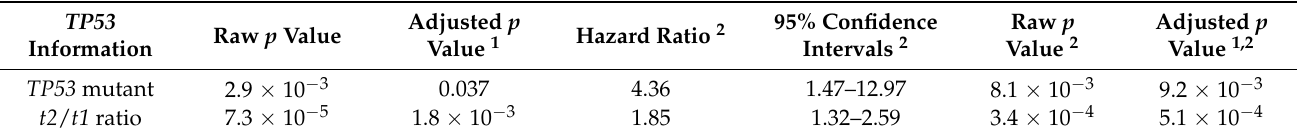
Figure 6. Association of TP53 tumor information with distant metastases free survival in NZ breast cancer patients. ( a ) Kaplan–Meier curves showing the proportion of patients having a distant metastatic event by their TP53 tumor mutation status (log rank test p = 0.0015). Red line = patients with tumors with a TP53 mutation ( n = 31), Blue line = patients with tumors with no TP53 mutation ( n = 58). ( b ) Forest plot showing contribution of TP53 tumor information and clinicopathological features to a multivariable Cox proportional hazards model predicting those patients having a distant metastatic event ( n = 83 with 27 patients developing distant metastases before 12 years, log rank test p = 4.2 × 10 − 8 ), CI = 95% confidence intervals, ( c ) Kaplan–Meier curves showing the proportion of patients having a distant metastatic event by their TP53 tumor mutation status and t2 / t1 transcript level ratios to stratify patients into four groups (log rank test p = 4.4 × 10 − 4 ). “High” = greater than median and “Low” = less than median levels of t2 / t1 , Green line = patients with tumors with High t2 / t1 levels and no TP53 mutation ( n = 27), Blue line = patients with tumors with High t2 / t1 levels and a TP53 mutation ( n = 16), Purple line = patients with tumors with Low t2 / t1 levels and no TP53 mutation ( n = 28) and Red line = patients with tumors with Low t2 / t1 levels and a TP53 mutation ( n = 14). Table 2. Cox univariable analysis of TP53 tumor information showing association with distant metastases free survival (DMFS) of patients with breast